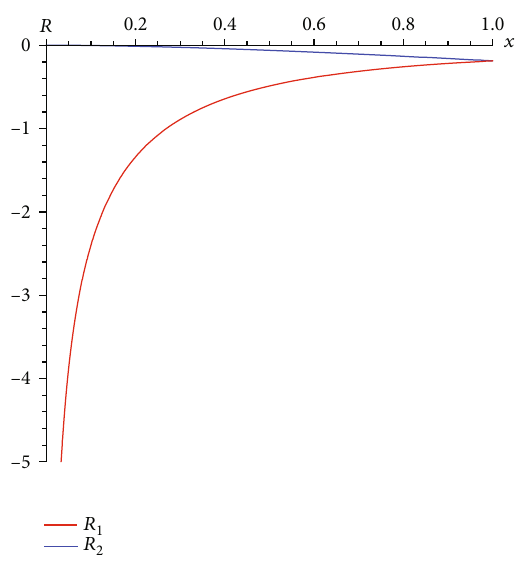
Figure 5: The Ricci scalar with di ff erent radios of black hole horizon radiuses for the parameter adoption 3